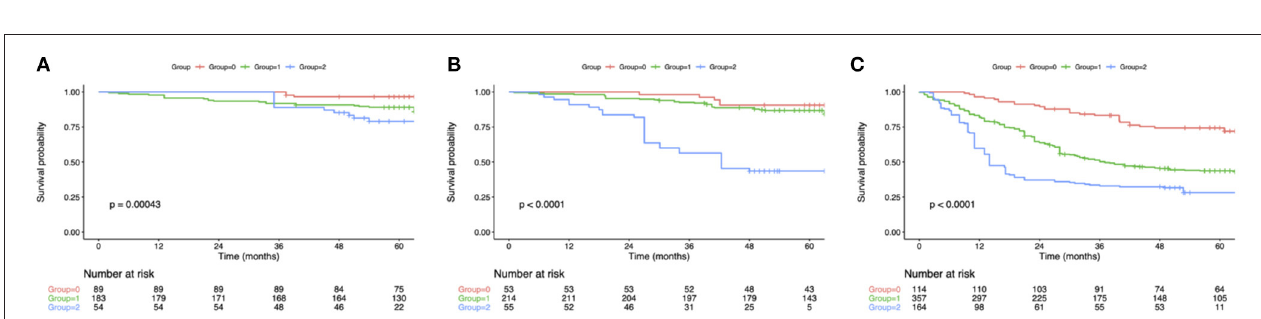
FIGURE 1 | (A) Kaplan–Meier survival analyses of OS according to the NPS score. (B) Kaplan–Meier survival analyses of OS according to the NPS group. OS, overall survival; NPS, naples prognostic score. (C) Association of the NPS with the OS in the adjuvant chemotherapy group. (D) Association of the NPS with the OS in the surgery alone group. OS, overall survival; NPS, naples prognostic score.